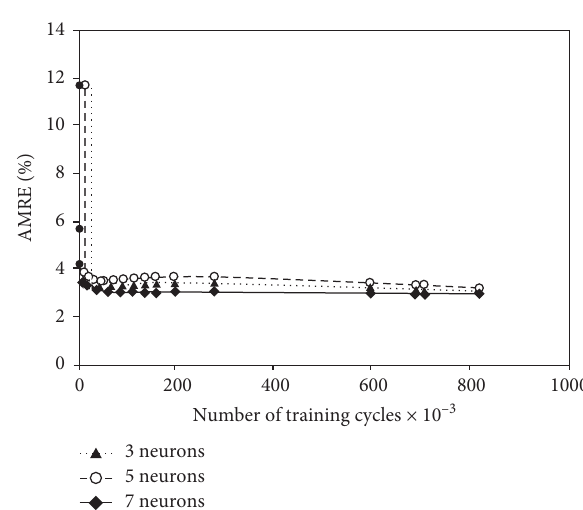
Figure 11: Proposed method with different neurons in hidden